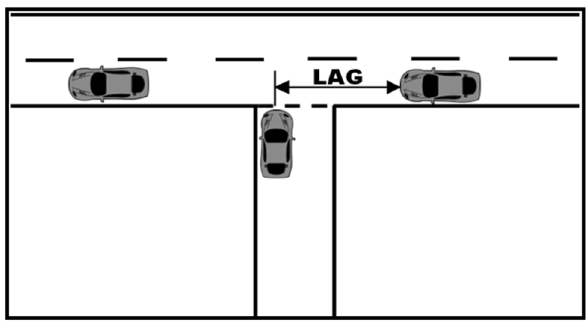
Fig. 2 Schematic diagram of lag